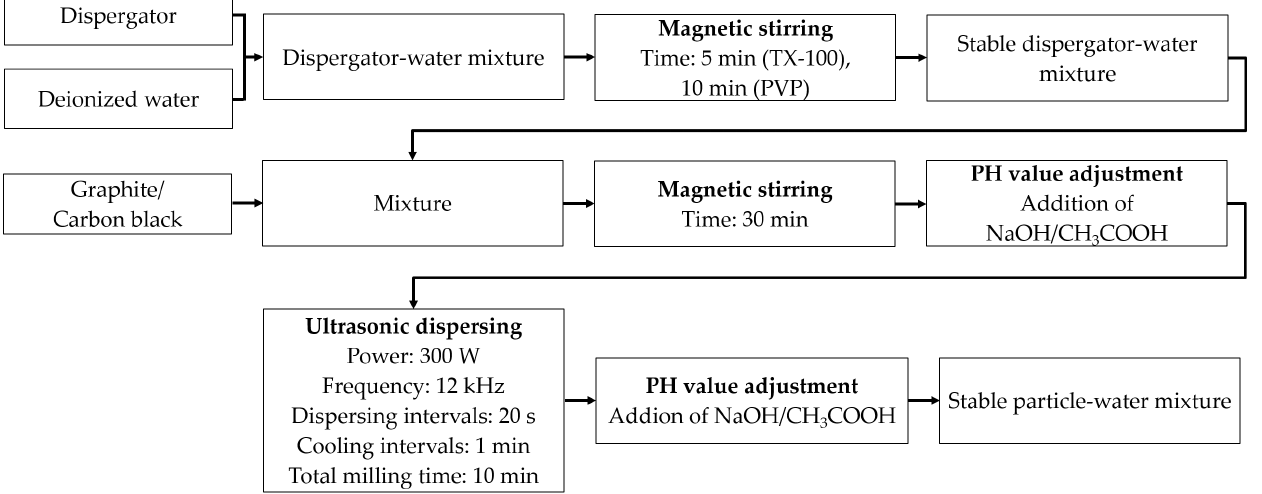
Figure 1. Flow chart showing the preparation process of the particle-water